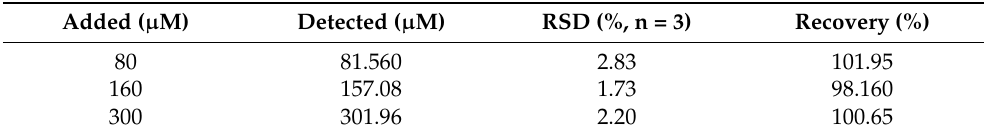
Table 2. Analytical results for the determination of H 2 O 2 in medical disinfectant samples.